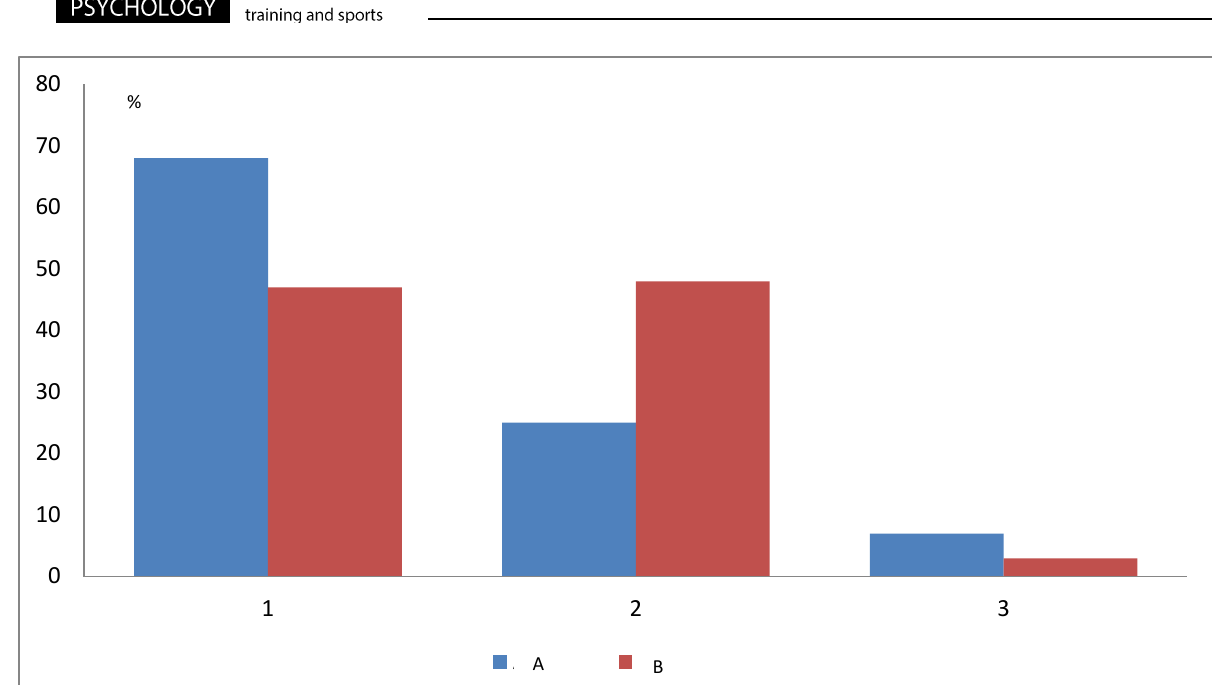
Fig.2. Attitude of 50-65 years’ age respondents to cigarette smoking: 1 – never smoked; 2 – gave up smoking; 3 – smoke minimum one pack a day.